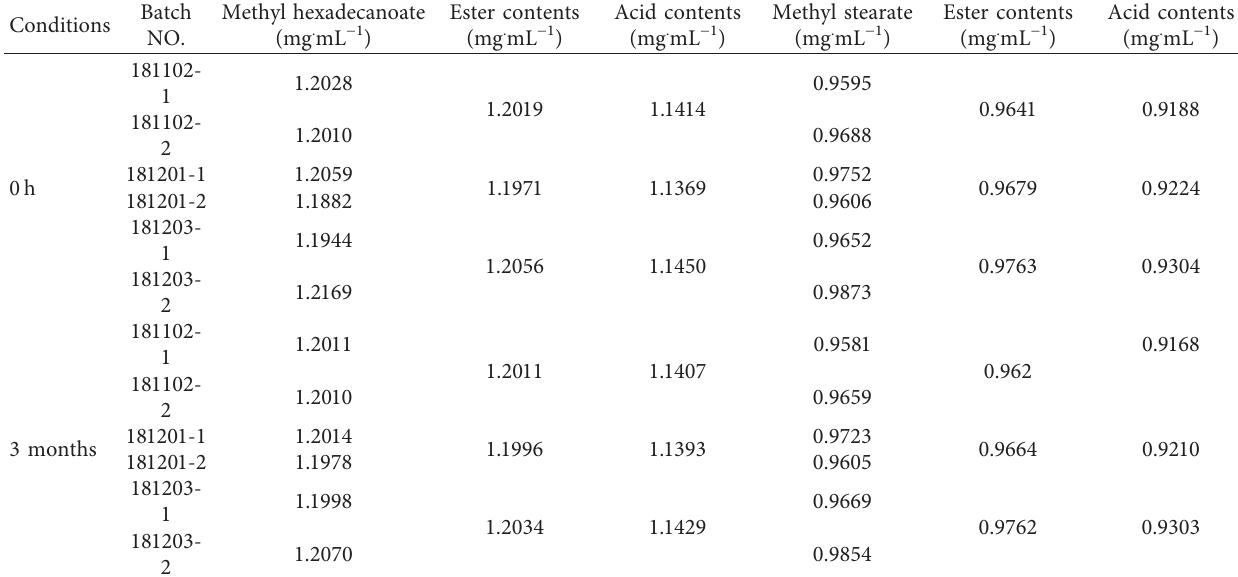
Table 4: Contents of target analytes in liposome injections.